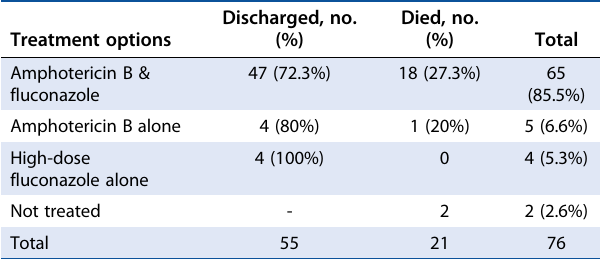
Table 3: Treatment given and outcome of patients admitted with cryptococcal meningitis